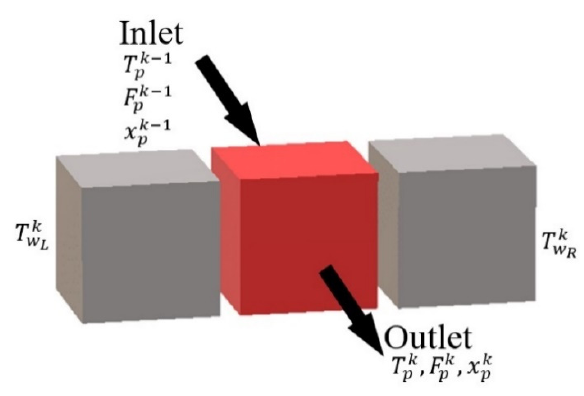
Figure 5. Representation of a cell k of process plate.